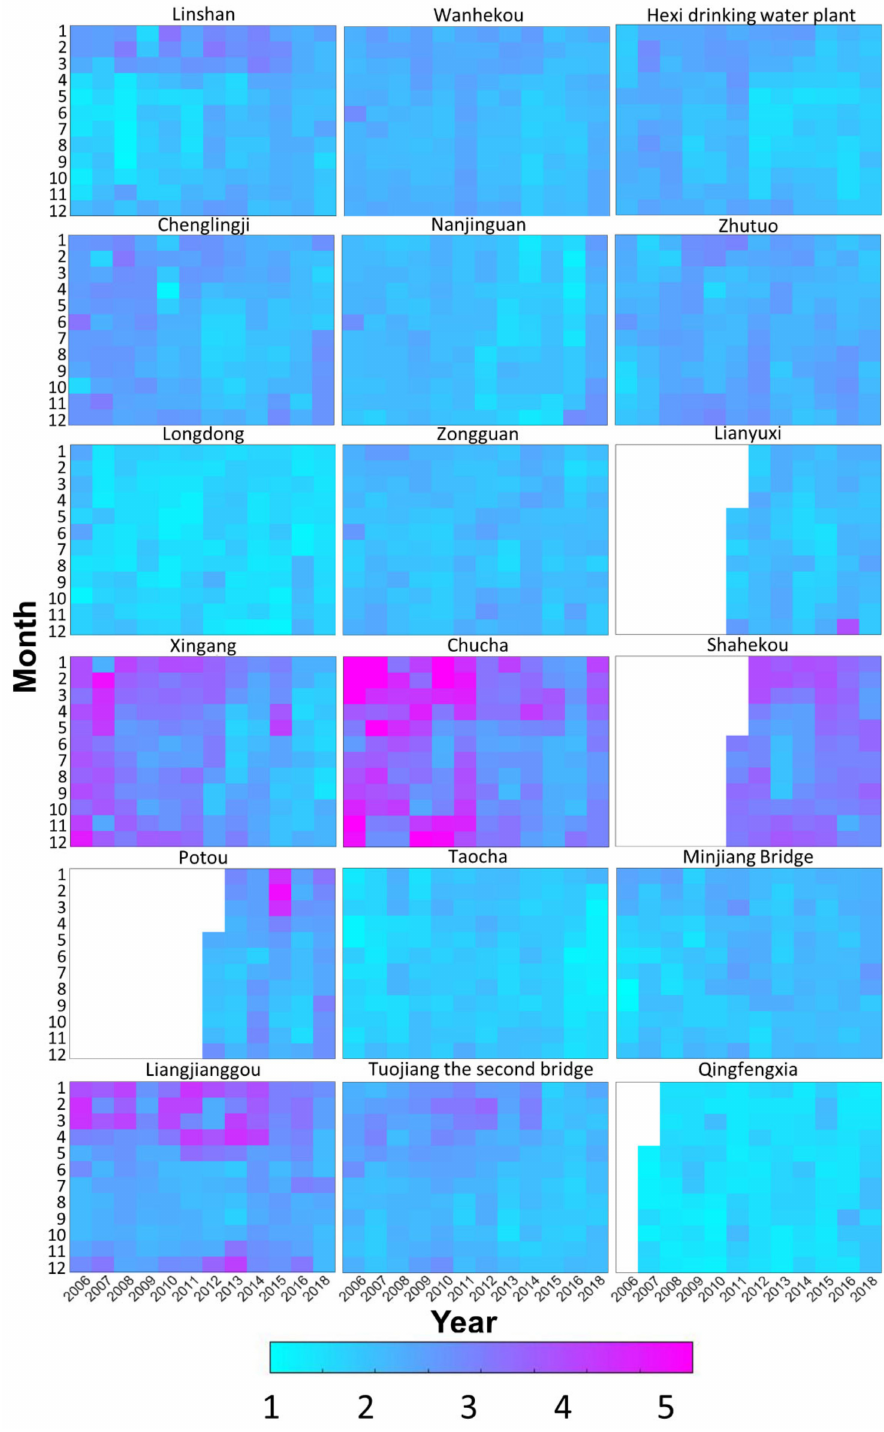
Figure 6. The monthly identification index of NH 3 -N of each monitoring section (white block indicates lack of monitoring data). The first seven sites are the trunk